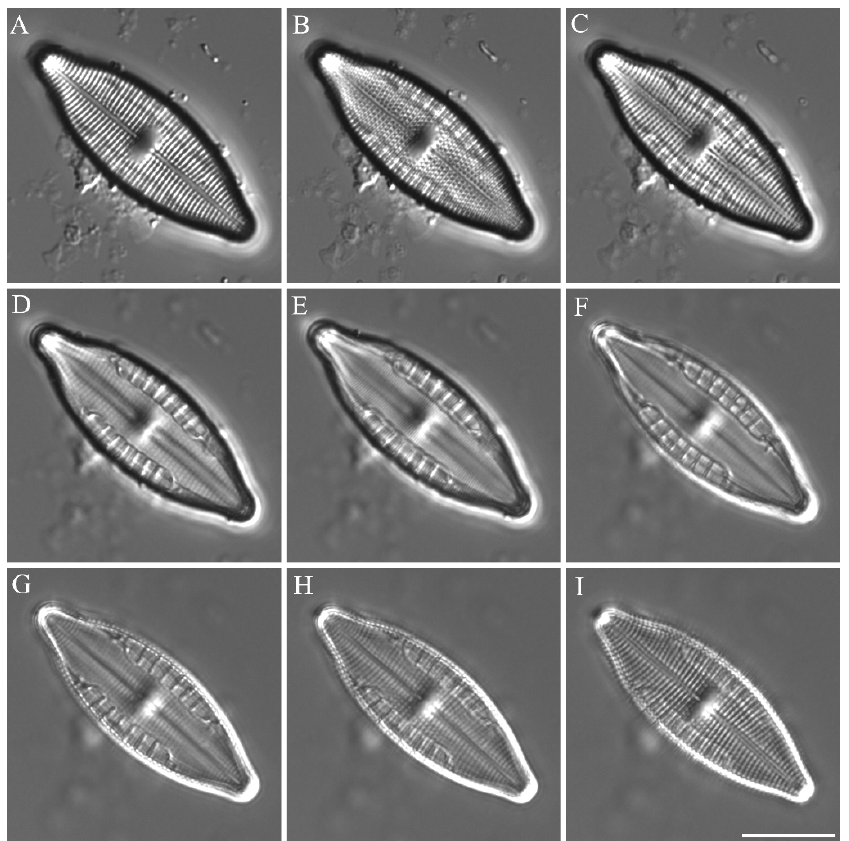
Figure 3. Light micrographs of Mastogloia elliptica in various depth of field ranges in microscope. ( A – C , I ) surface focus of valve face with uniseriate striae ( D – H ) Deeper focus with similar sized numerous partecta (arrows). Scale bar:10 µm.